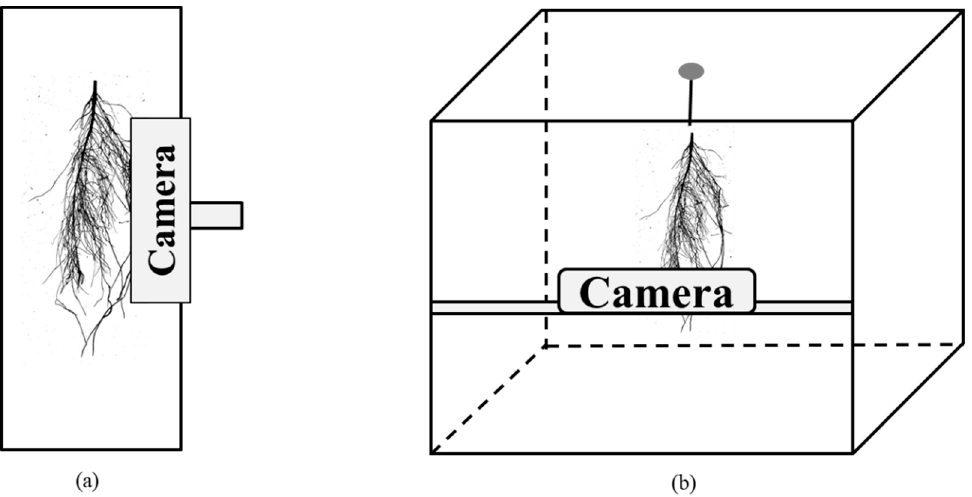
Figure 1. Two methods of collecting two-dimensional images. ( a ) horizontal root crown method in which the roots are placed on a flat surface, and the camera is placed above the roots; ( b ) vertical root crown method in which the root is hung from the roof and the camera is placed in front of the hanging root.